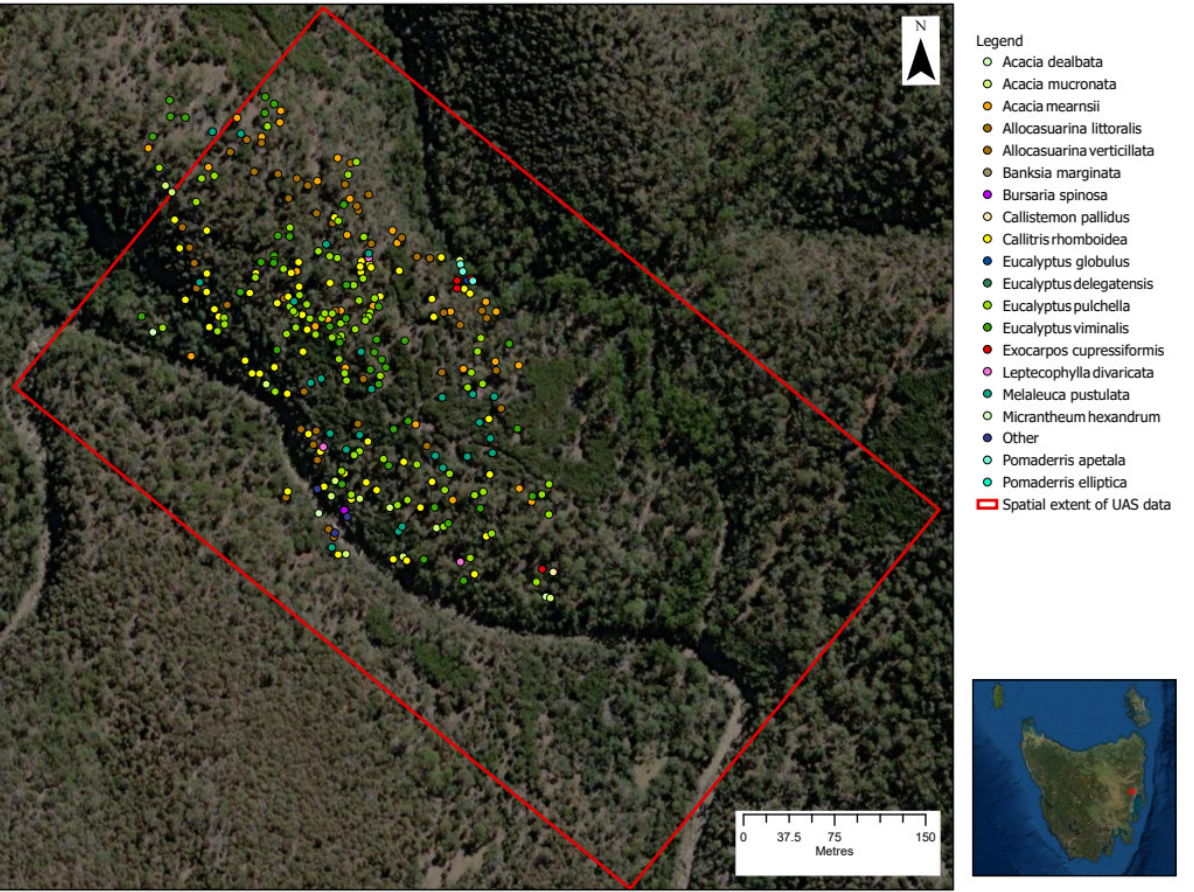
Figure 2. Inset map shows location of study site in the East Coast region of Tasmania. Map shows spatial extent of UAS data and ground data points on tree species.